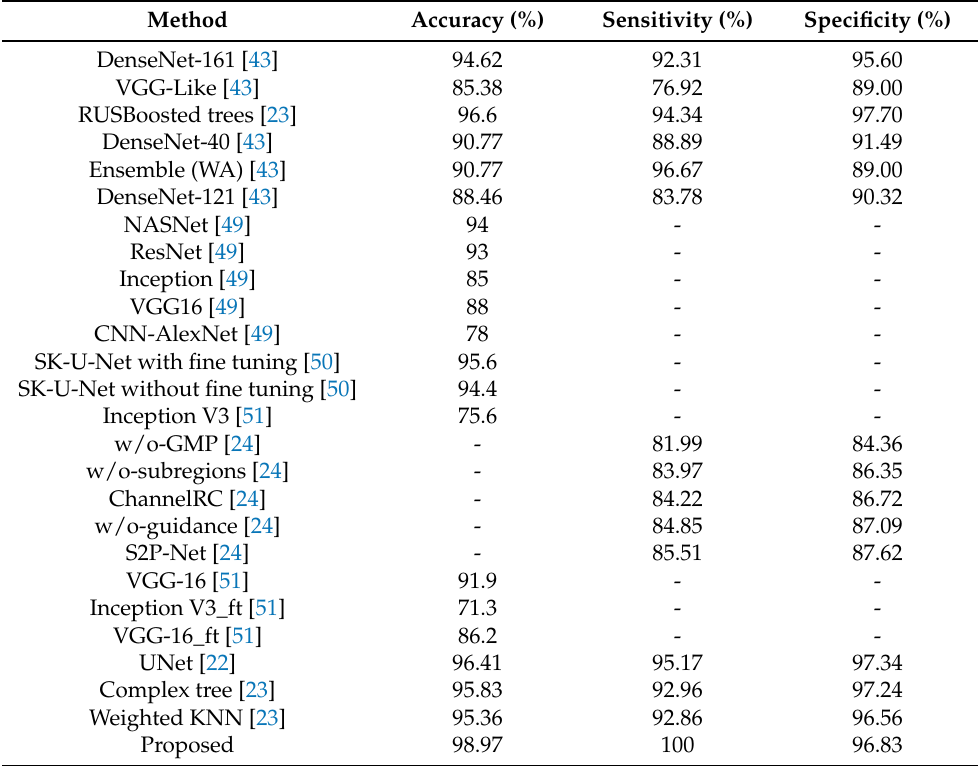
Table 11. Comparison of previous methods with the proposed